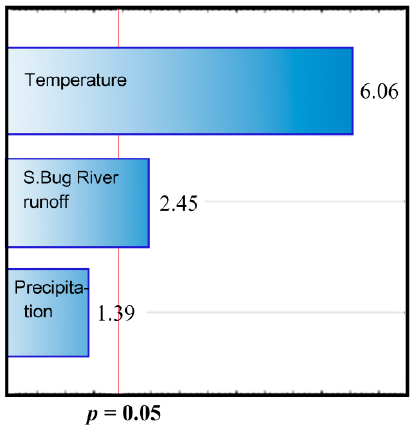
Figure 15. Diagram of values of standardized weights, sorted by absolute value for variables of a regression, which reveals the dependence of groundwater flow on temperature, average monthly river discharge and monthly precipitation for the period 1980–2016. Red vertical line—limit of significant coefficients (factors).